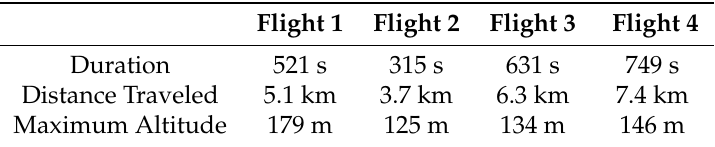
Table 7. Experiments information.